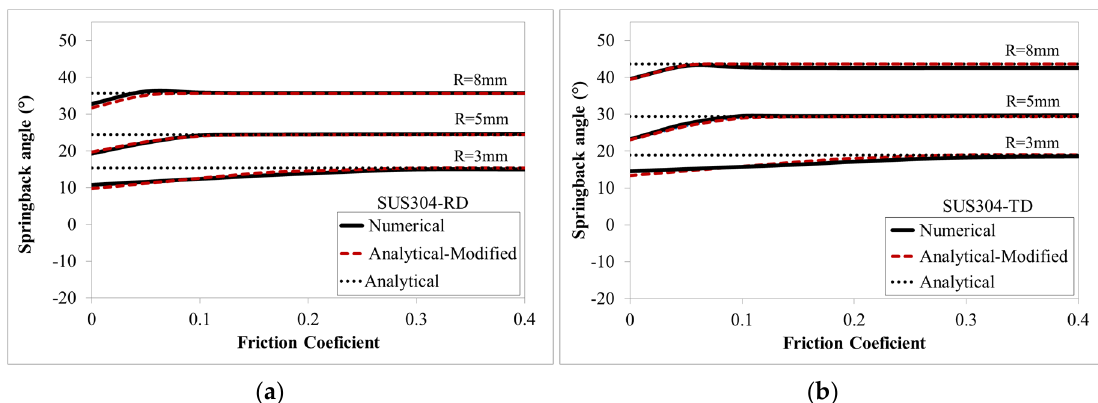
Figure 14. Springback relationship with the friction coefficient for different bending in the ( a ) rolling direction and ( b ) transverse direction.